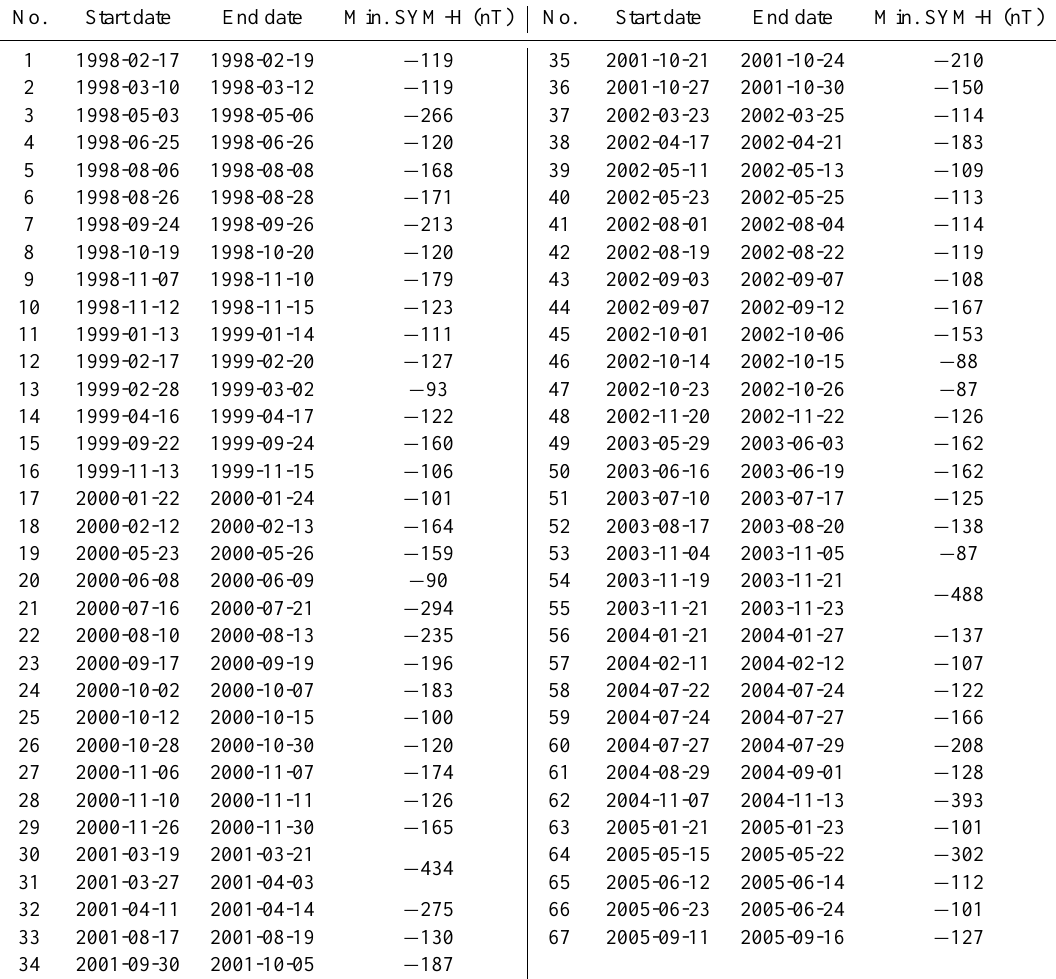
Table 1. Storm intervals used to develop the ANN prediction